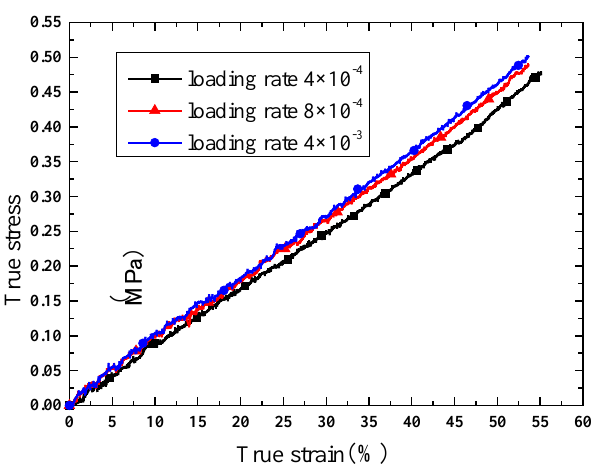
Figure 9. True strain versus stress curves of pure silicone at different loading rates (aging time: 0 h, mass fraction: 0%).